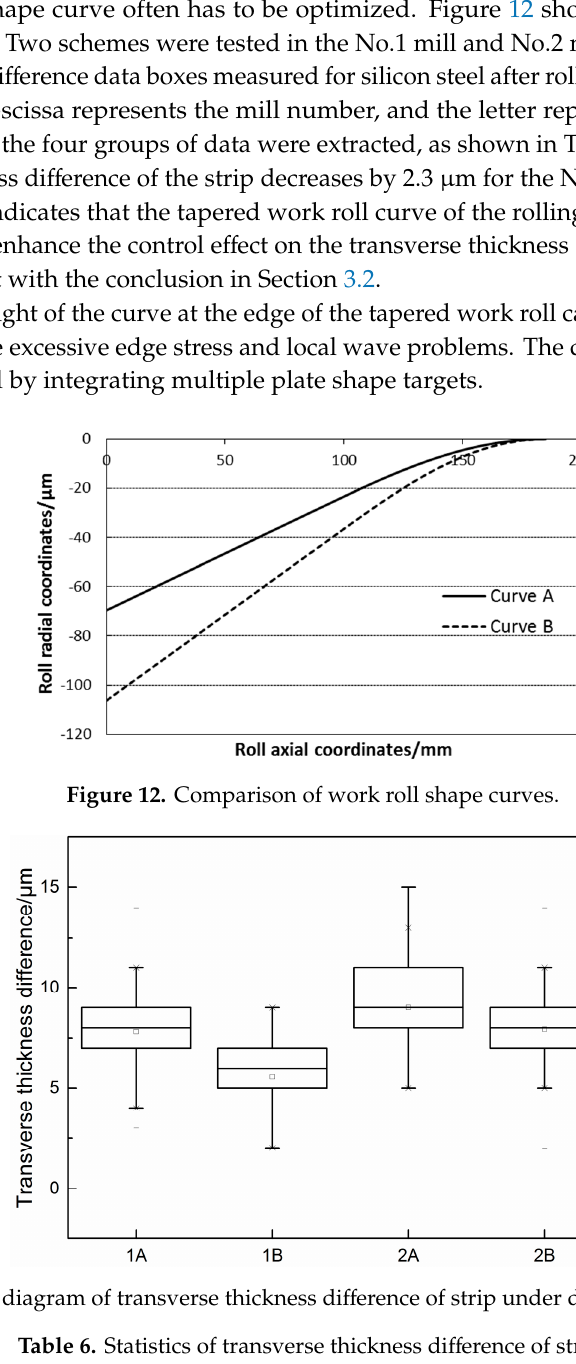
Figure 11. Typical section shape comparison of strip produced by different mills.